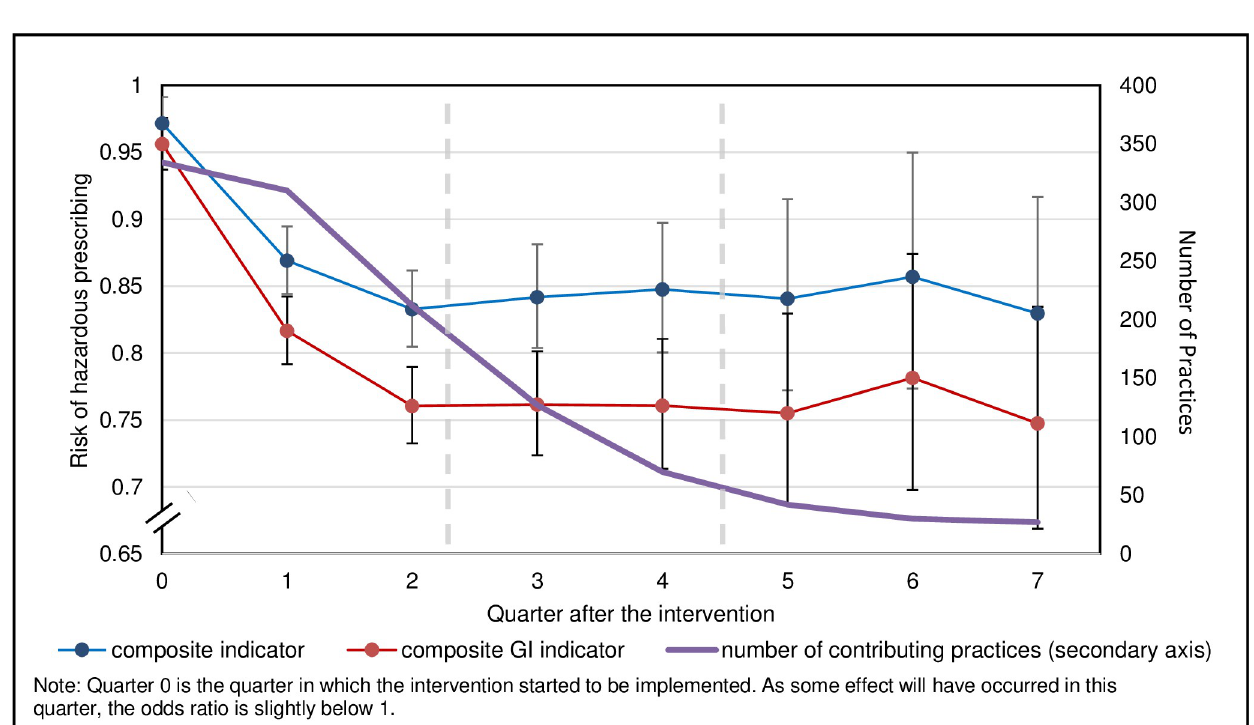
Fig 2. Odds ratio and 95% confidence intervals for the rate of hazardous prescribing at each quarter interval compared to preintervention for the composite outcomes.